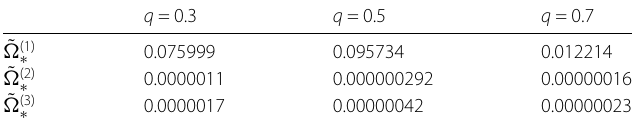
Table 1 Numerical values of